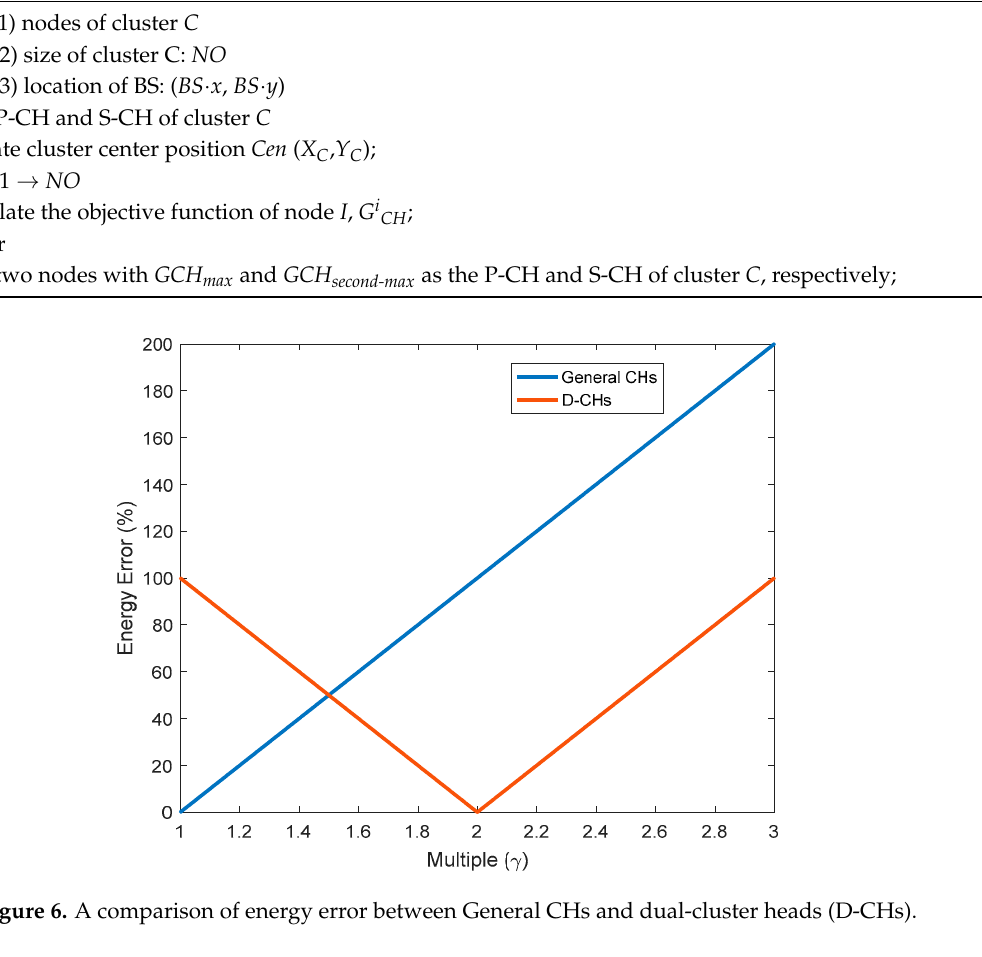
Algorithm 3. P-CH and S-CH Selection Algorithm (Large Cluster of Stable Period)